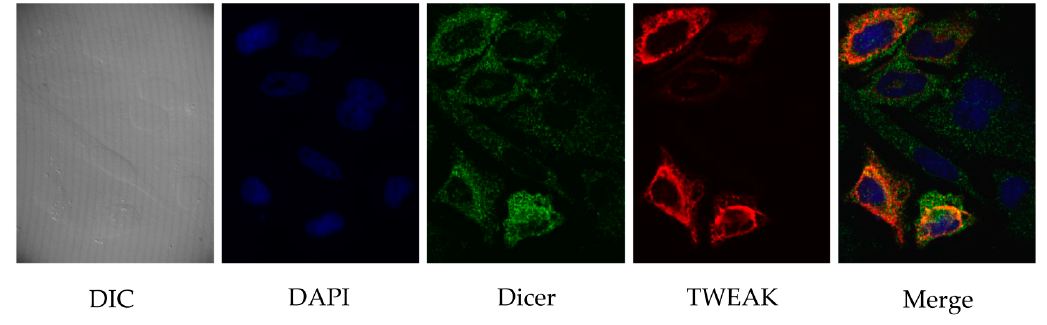
Figure 2. Cytoplasmic/perinuclear colocalization of Dicer and TWEAK proteins in human cells. Flag ‐ TWEAK and human Dicer proteins were expressed in cultured HeLa cells prior to confocal immunofluorescence microscopy. TWEAK was labeled with a rabbit polyclonal anti ‐ FLAG and a secondary anti ‐ rabbit ‐ IgG coupled to AlexaFluor 546 fluorophore (in red), whereas Dicer was labeled using a monoclonal anti ‐ Dicer antibody and a secondary murine anti ‐ IgG coupled to AlexaFluor 488 fluorophore (in green). Cell nuclei were labeled with 4 ′ ,6 ‐ diamidino ‐ 2 ‐ phenylindole (DAPI). Proteins were visualized using a confocal microscope (Quorum spinning Disc Wave Fx, Quorum Technologies, Guelph, ON, Canada) and a 63× objective. DIC, differential interference contrast.